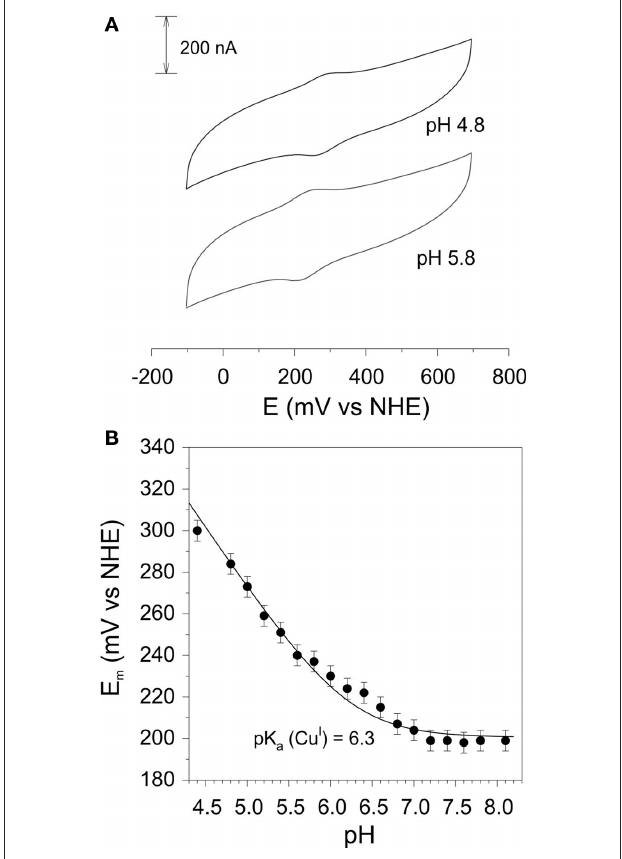
Figure 5 | (A) Cyclic voltammograms of rAzu2 at a 11-mercaptoundecanoic acid-modified Au working electrode at pH 4.5 and 5.5 (sweep rate 50 mV/s) (B) pH-dependence of the redox potential. Curve is the best fit to the data using Eq. 2 which gave a pK of 6.3 for the reduced (Cu I ) form of rAzu2. a Experimental conditions: sweep rate 50 mV/s, 0.1 M phosphate titrated with NaOH or acetic acid to the